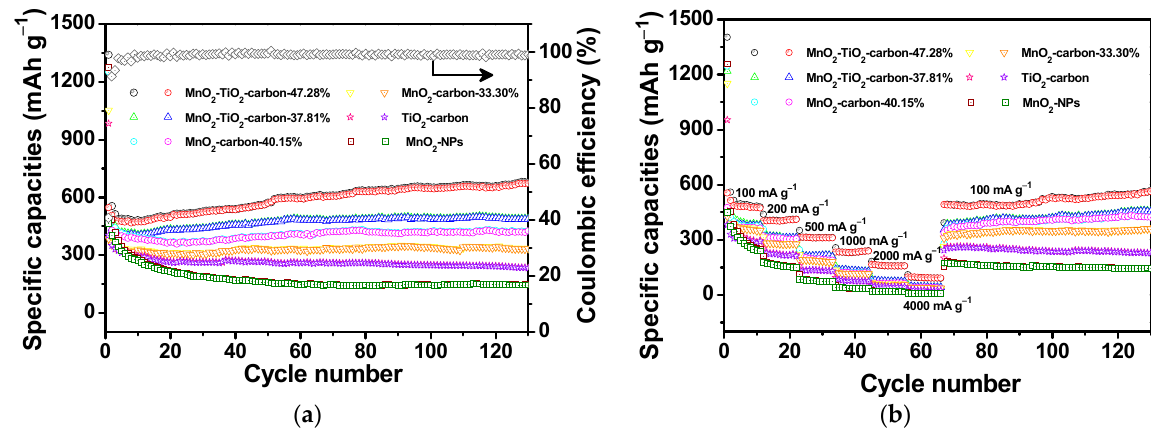
Figure 9. ( a ) Cycling performances of MnO 2 -TiO 2 -carbon-47.28%, 37.81%, MnO 2 -carbon-40.15%, 33.30% composites, TiO 2 -carbon and MnO 2 -NPs electrodes at a current density of 100 mA g − 1 as well as the Coulombic efficiency curve of the MnO 2 -TiO 2 -carbon-47.28% composite. ( b ) Rate performances of the corresponding electrodes at various current rates. Table 1. The comparison of the electrochemical performances of the nanofibrous MnO 2 -TiO 2 -carbon composite with other reported analogous MnO 2 -based composites used as anodic materials for lithium-ion